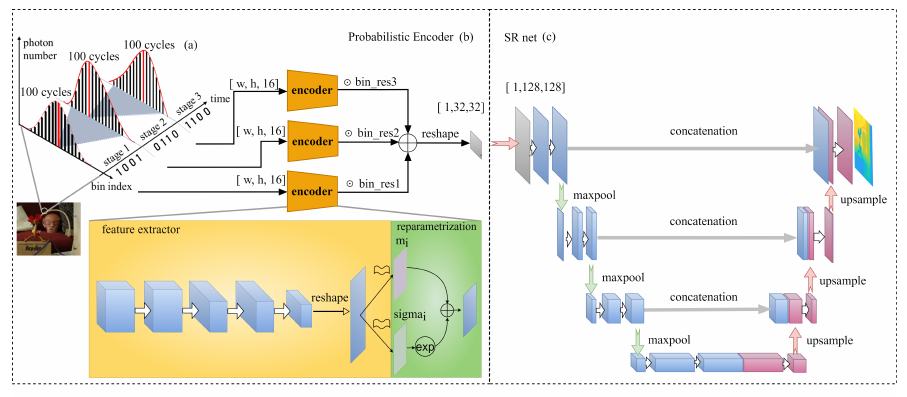
Figure 2. Architecture of the proposed neural network: ( a ) Sampling procedure of multi-scale histogram mode. In this experiment, in each stage, the VCSEL on hardware is driven 4 k times. According to the returned TDC results, the peak range is zoomed in the next stage. ( b ) Probabilistic en- coder structure, which combines the CNN-based encoder part and the reparametrization trick. U-Net based SR-Net is shown in ( c ). SR-Net is responsible for the up-sampling task in this neural network. The three histograms are constructed using different gratuities of the 12-bit